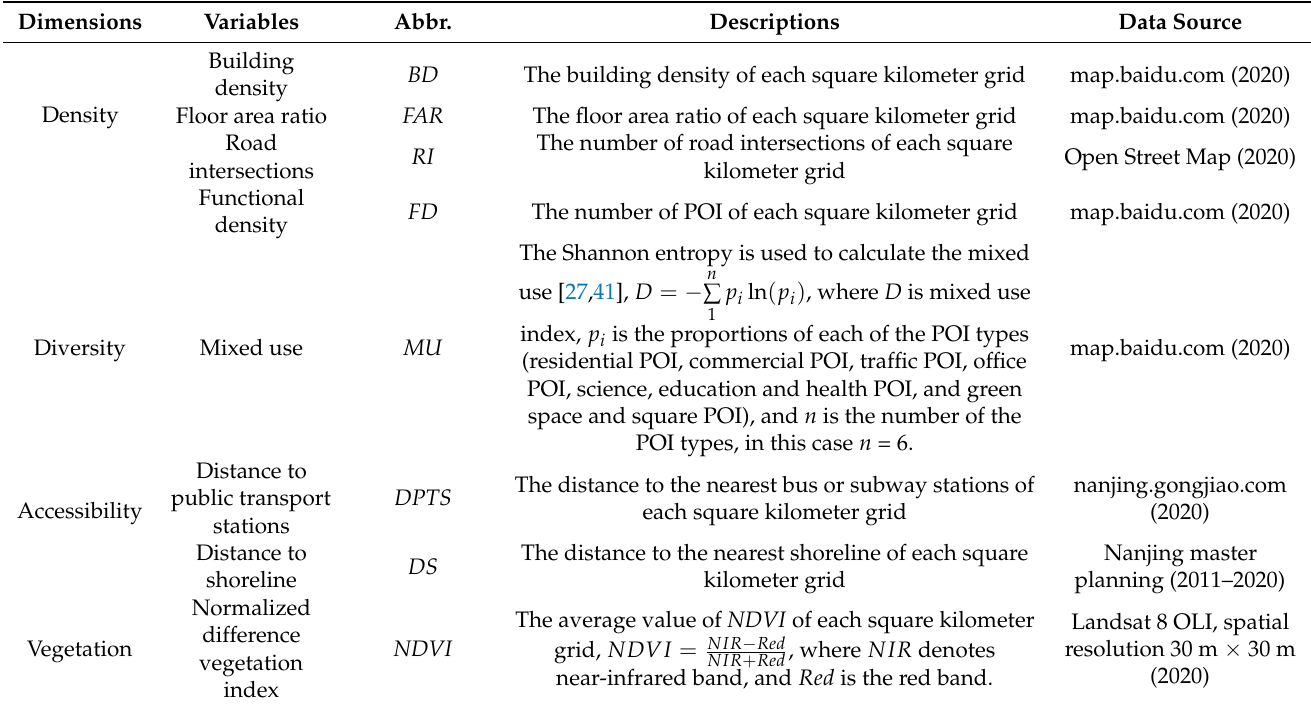
Table 1. Description of built environment